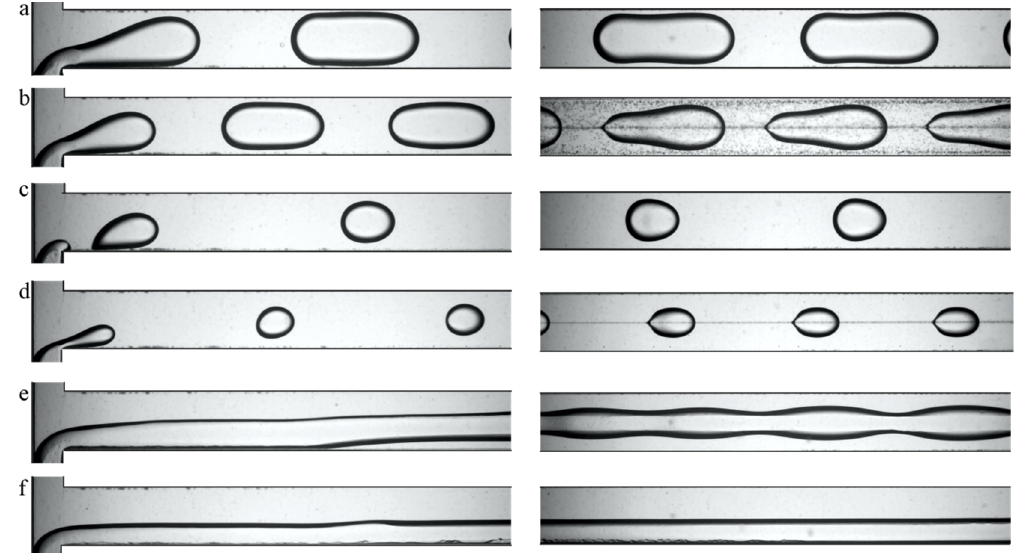
Figure 3. Typical flow patterns for the flow of CMC 0.5%–castor oil at a T-junction and the end of microchannel: ( a ) slug flow, ( b ) slug flow with microdroplets, ( c ) droplet flow, ( d ) droplet flow with microdroplets, ( e ) rivulet flow, and ( f ) parallel flow.